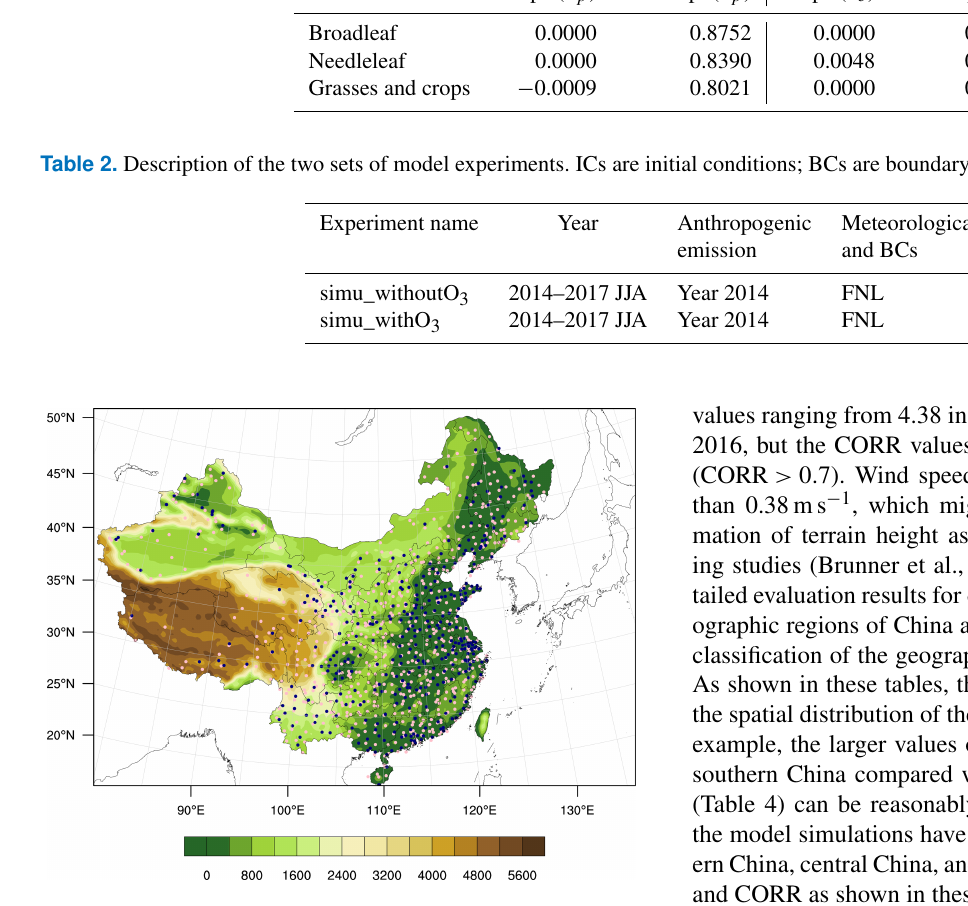
Figure 2. Site locations of air quality monitoring sites (blue dots) and the meteorological monitoring sites (pink dots), and terrain height (m) shown by the color